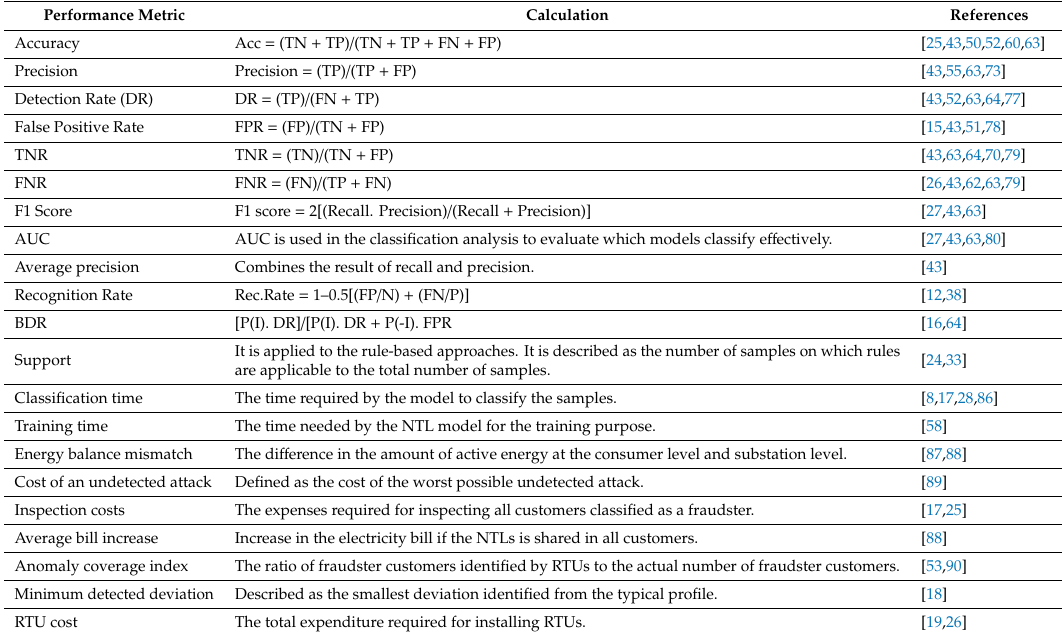
Table 4. Performance metrics used for evaluation for NTL detection methods.